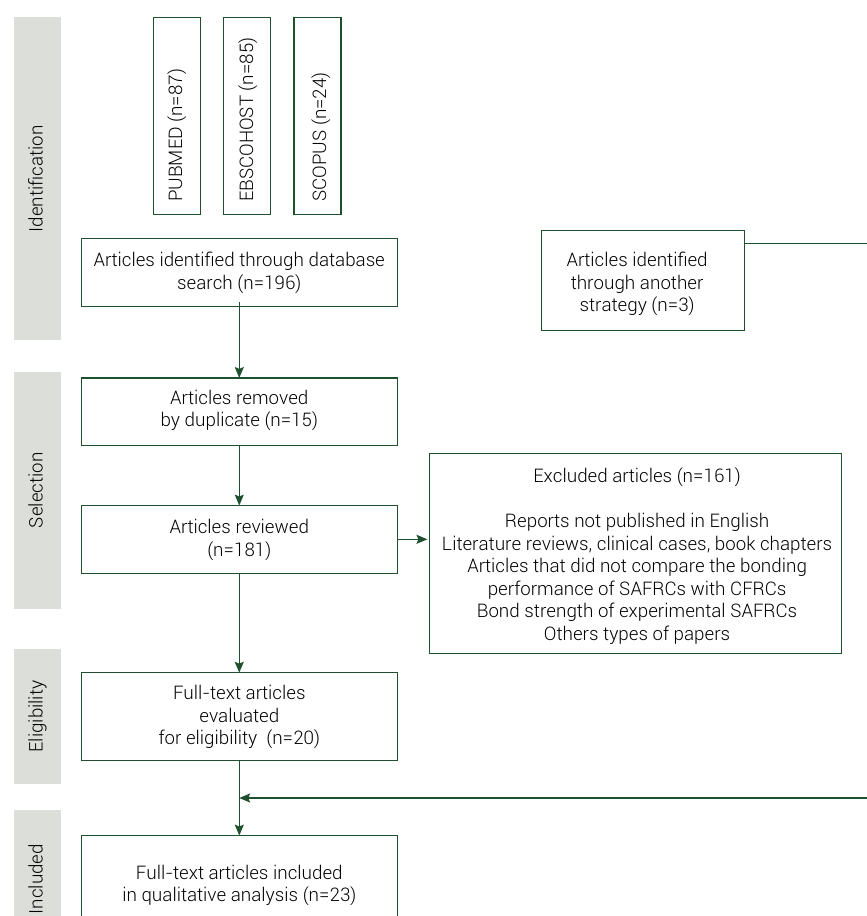
Figure 1. Selection process, according to PRISMA